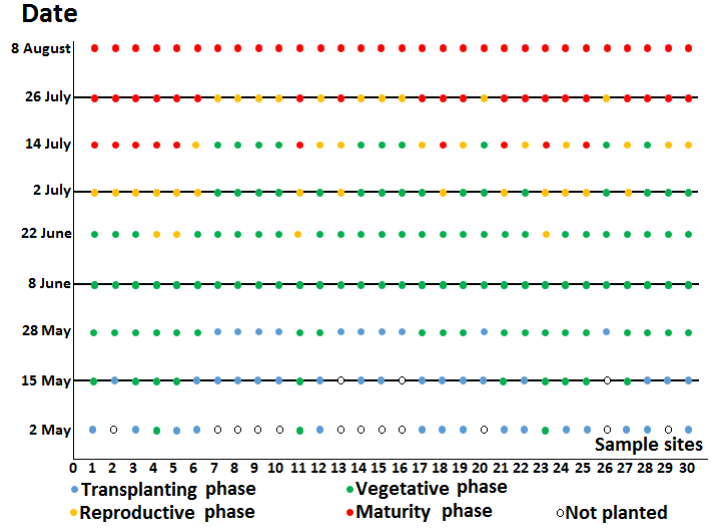
Figure 3. In situ rice phenology at 30 sample sites in 2016. Blue, green, yellow, and red dots, respectively, represent the transplanting, vegetative, reproductive, and maturity phase. Four horizontal lines denote the acquisition dates of four RADARSAT-2 datasets.